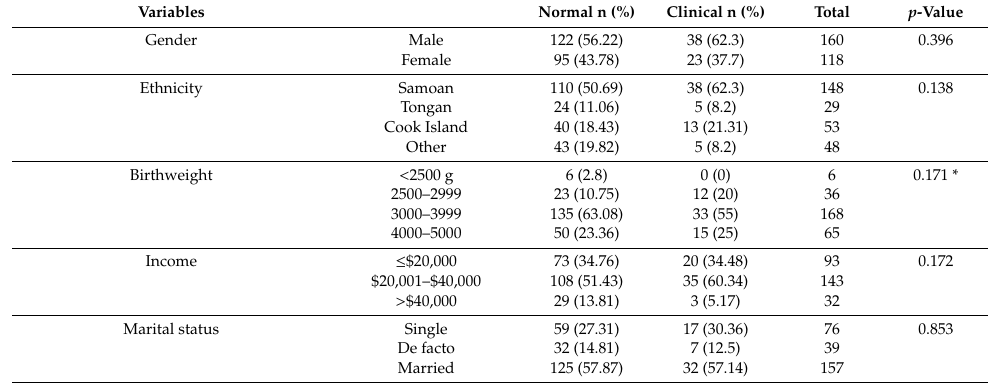
Table 1. Summary descriptive results for behavioral outcomes (normal: n = 217; clinical: n = 61) based on CBCL